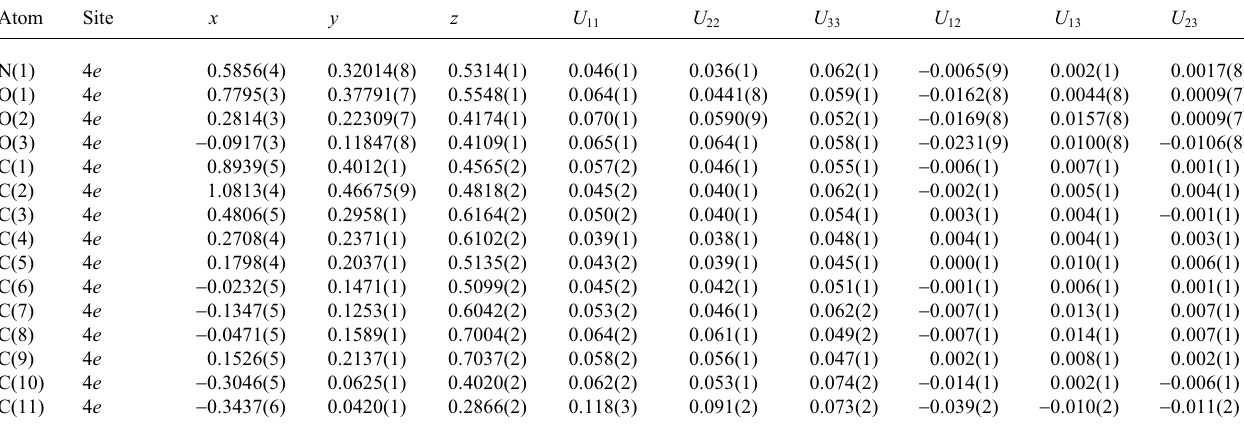
Table 3. Atomic coordinates and displacement parameters (in Å 2